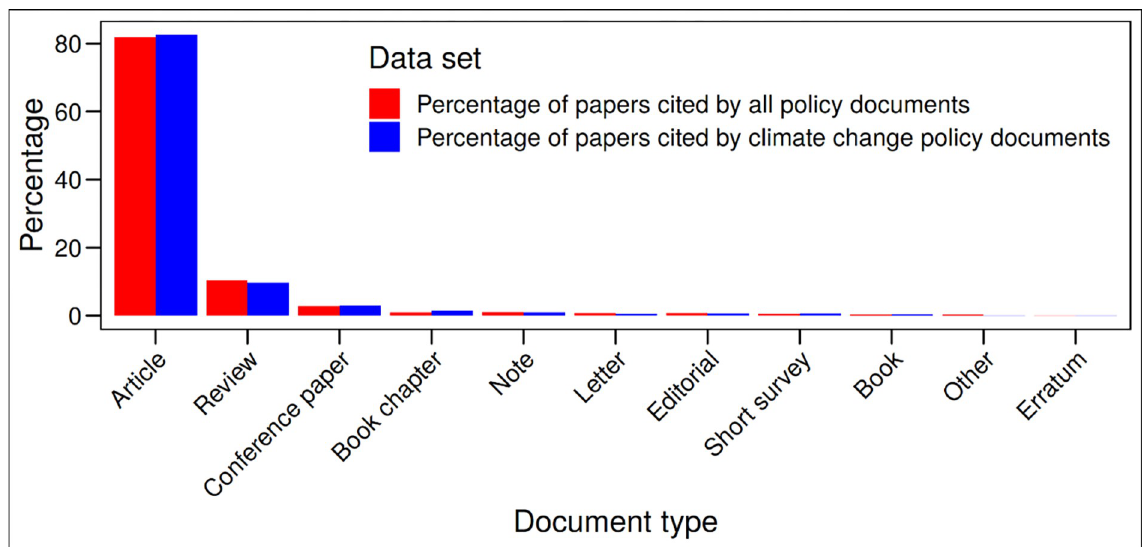
Fig 4. Document type of papers cited by policy documents (all policy documents and climate change policy